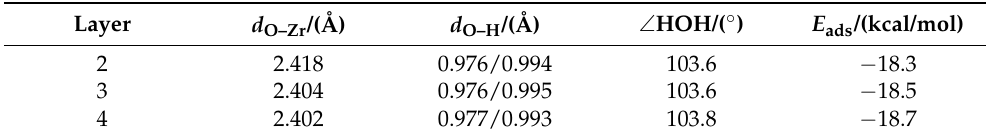
Figure 1. Structure of a water molecule adsorbed on two-layer ( a ), three-layer ( b ) and four-layer ( c ) models of the monoclinic ZrO 2 (111) surface. Table 1. Structural parameters and adsorption energies of a water molecule on different models of the ZrO 2 surface.